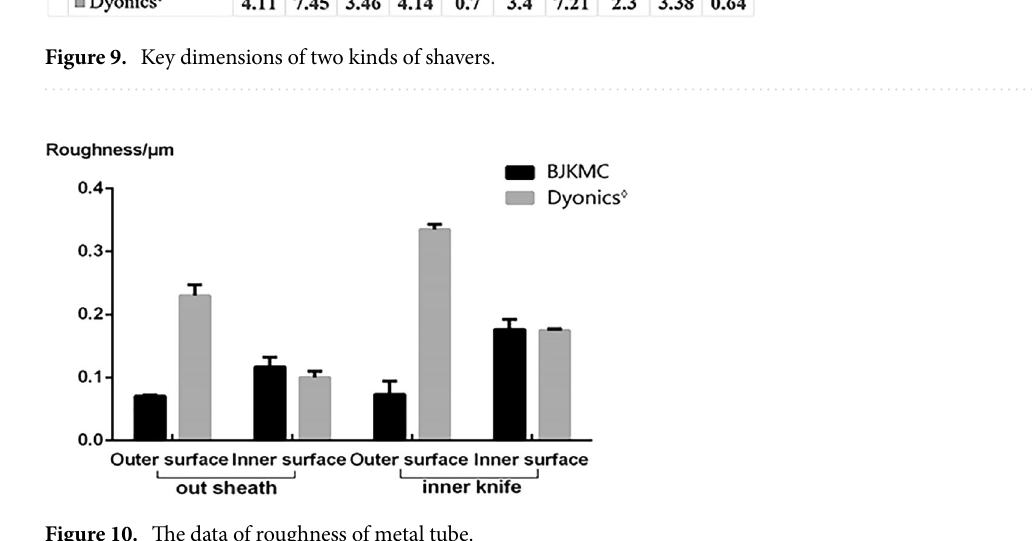
Figure 10. The data of roughness of metal